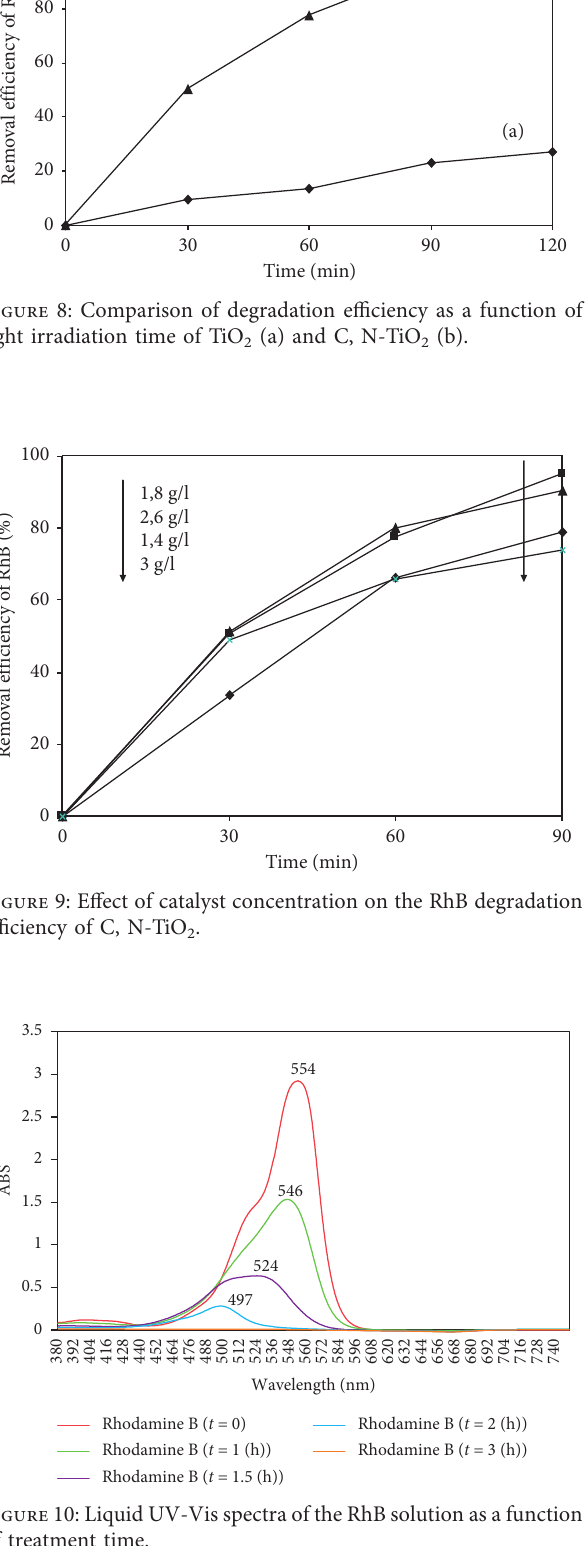
Figure 10: Liquid UV-Vis spectra of the RhB solution as a function of treatment time.